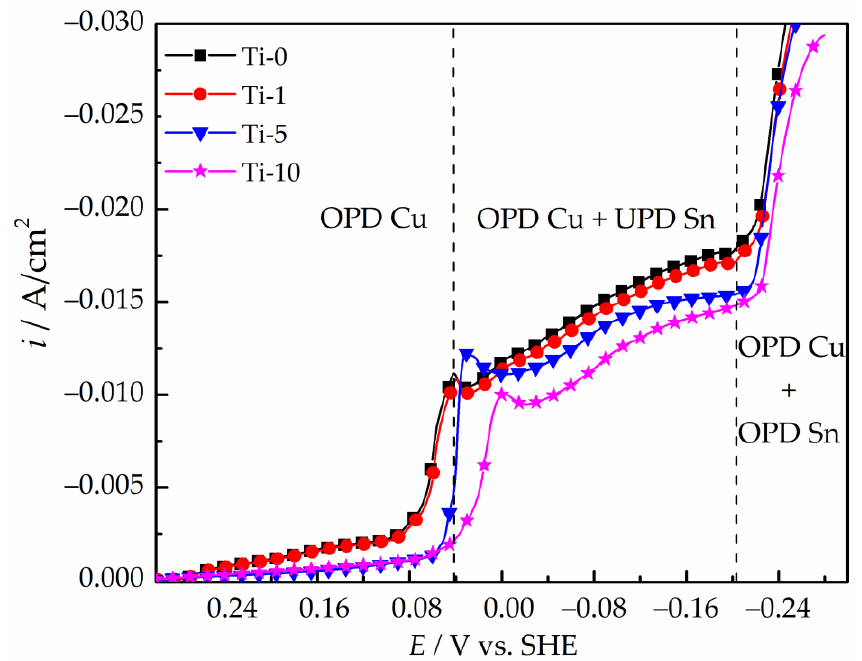
Figure 2. Cathodic polarization curves of copper electrode in sulfate electrolytes of Cu–Sn–TiO 2 deposition.